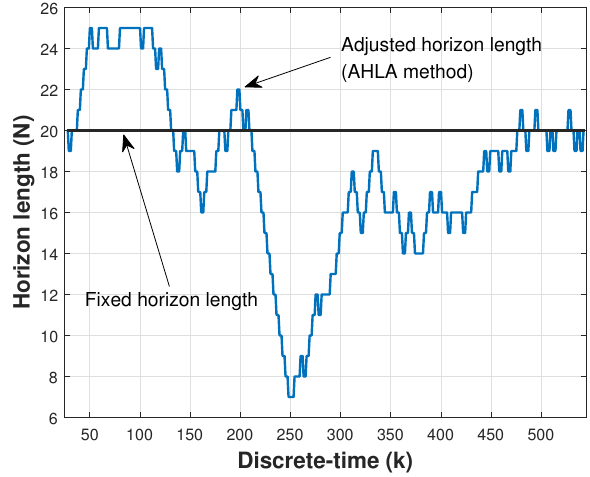
Figure 5. Adjusted horizon length using the AHLA method.